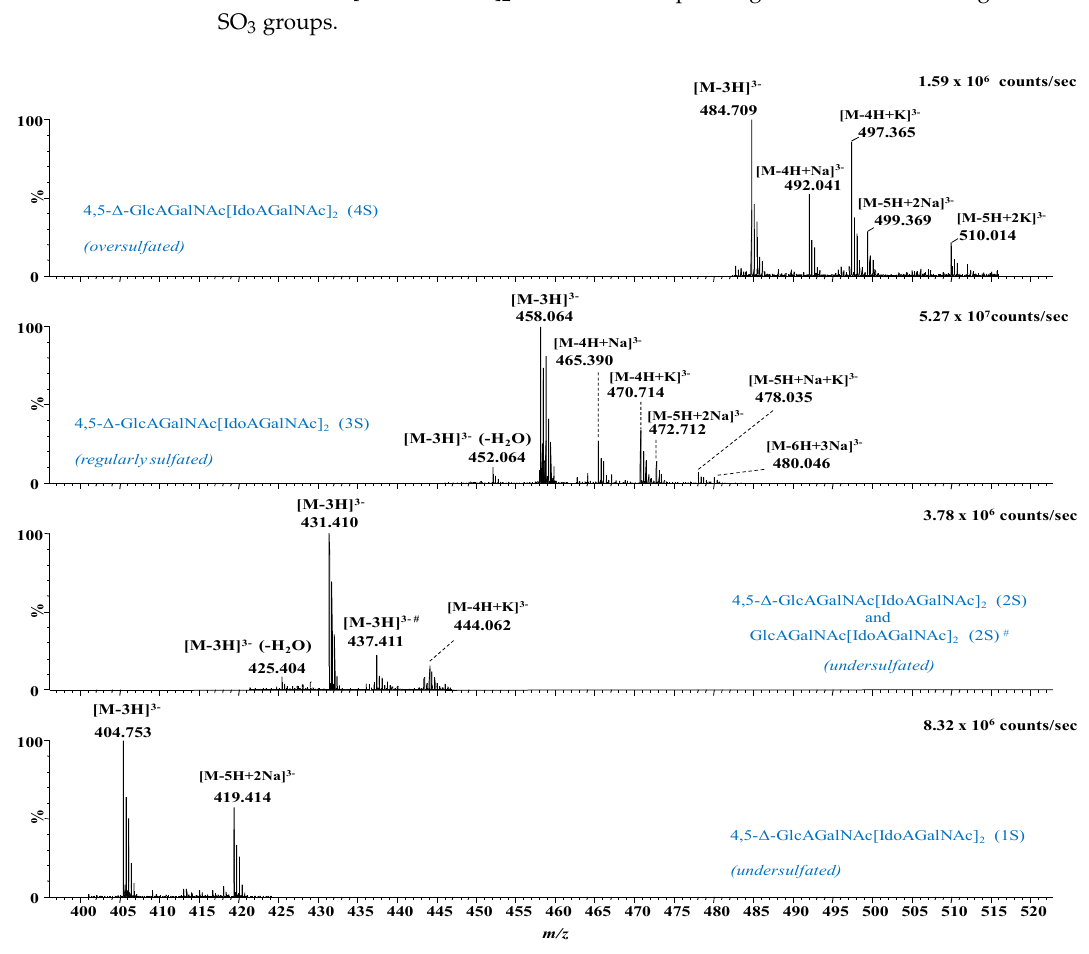
Figure 4. Extracted (-) nanoESI IMS mass spectra of triply charged mono- to tetrasulfated 4,5- Δ -GlcAGalNAc[IdoAGalNAc] 2 from the corresponding areas indicated in Figure 2. n S-number of SO 3 groups; #—saturated structure.